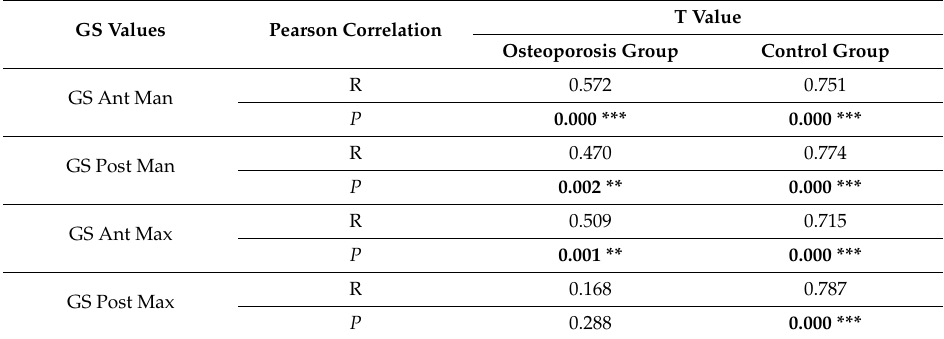
Table 3. Correlations between T value and GS values at di ff erent jaw regions for osteoporosis group and